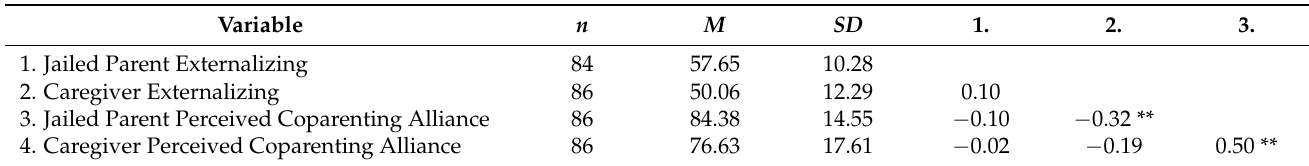
Table 2. Study variables means, standard deviations, and bivariate correlations.